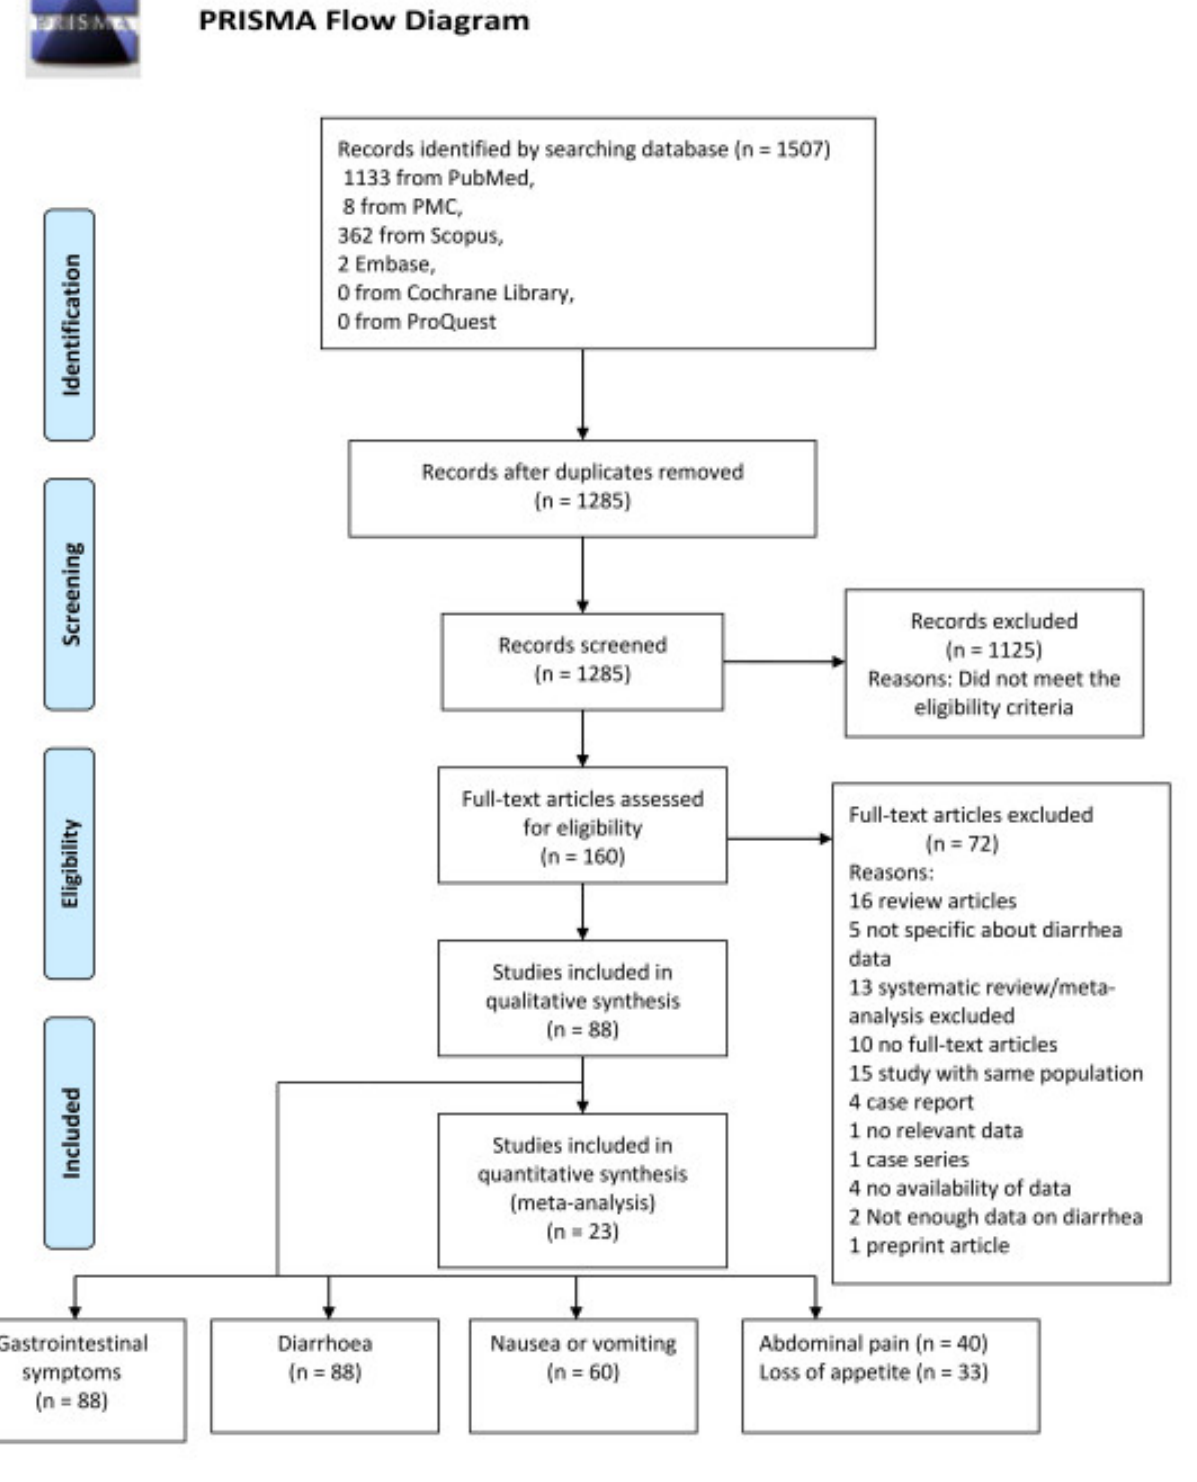
Figure 1. PRISMA flow diagram.